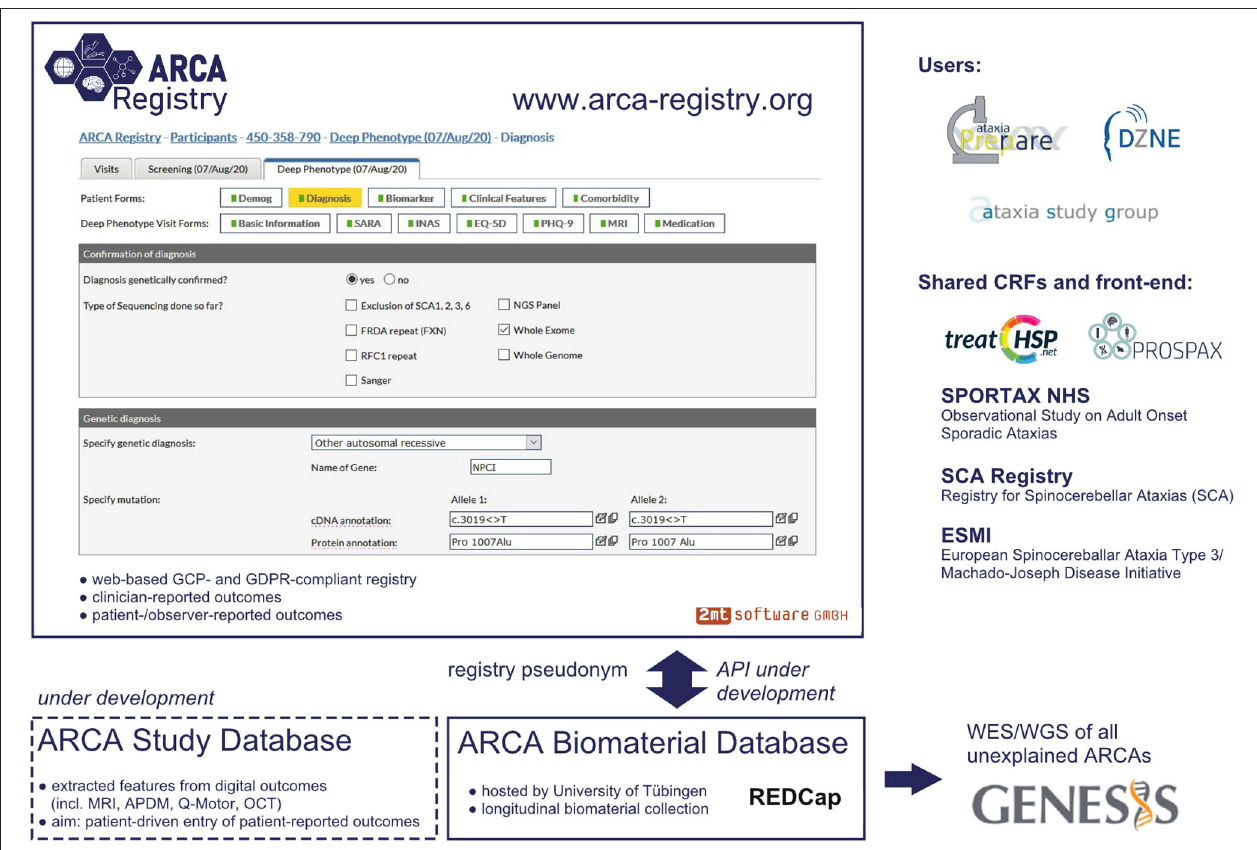
FIGURE 1 | Platform and database infrastructure of the ARCA Registry. Graphical user interface of the web-based ARCA Registry, with display of a representative electronic case report form (eCRF) and embedding in the larger database infrastructure. The front-end of the software and the main core of eCRFs are shared with other major ataxia and rare disease registries (e.g., the HSP registry used by the TreatHSP network), making the ARCA Registry user friendly and convenient for joint analysis of data across genetic ataxias, sporadic ataxias, and hereditary spastic paraplegia (HSP)